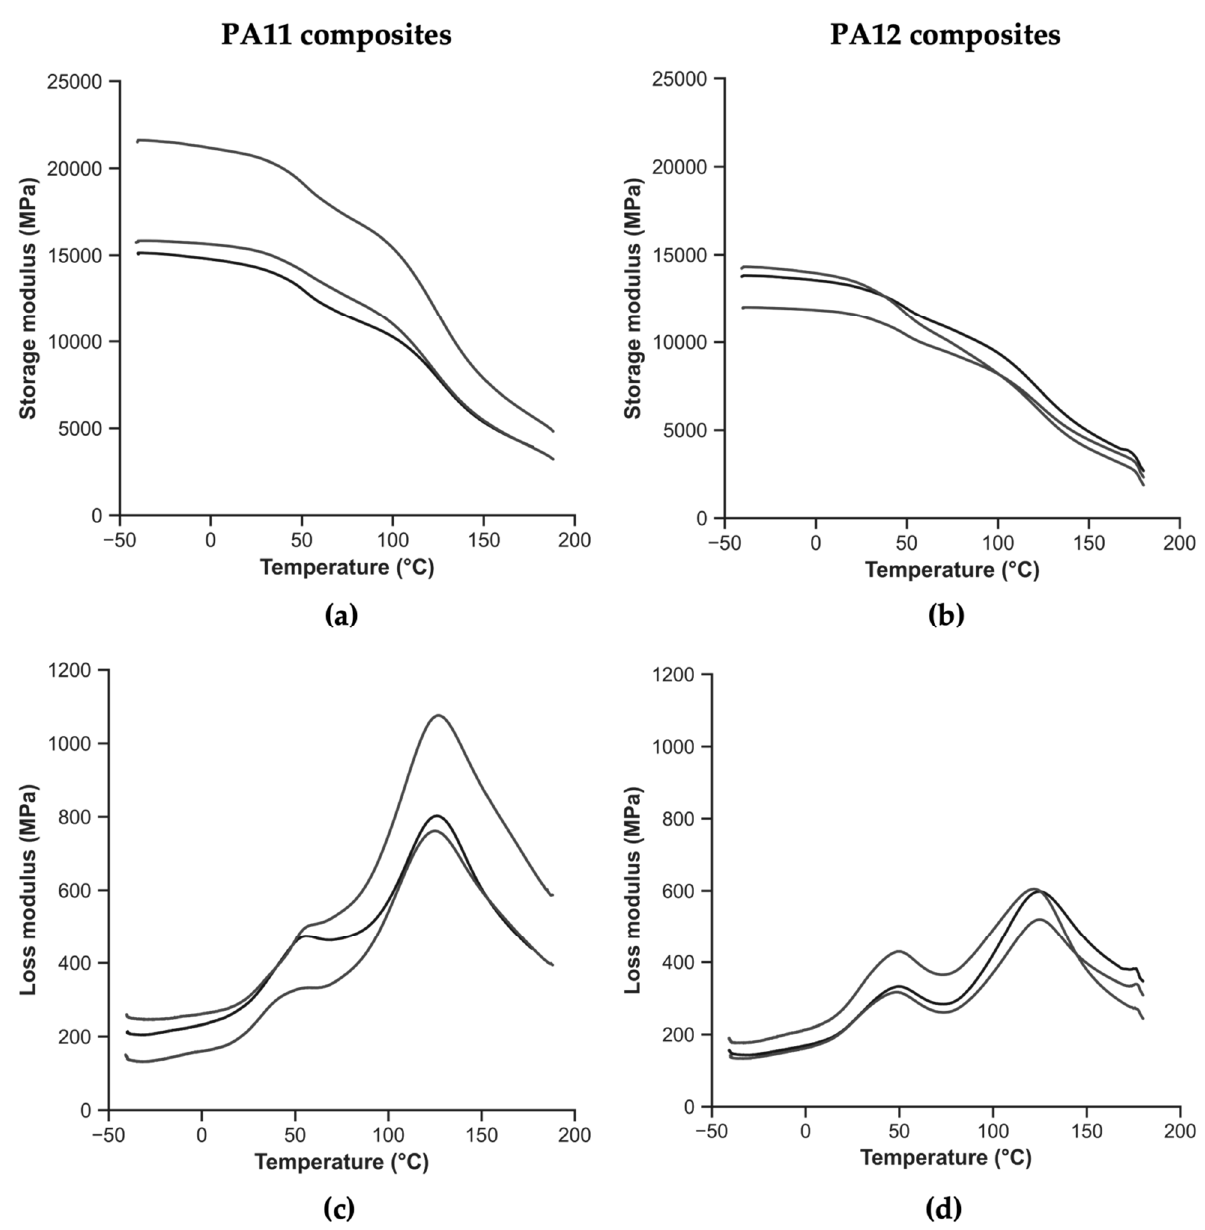
Figure 10. Thermomechanical behavior of composites: ( a ) storage modulus as a function of temper- ature for PA11 composites, ( b ) storage modulus as a function of temperature for PA12 composites, ( c ) loss modulus as a function of temperature for PA11 composites, and ( d ) loss modulus as a function of temperature for PA12 composites.